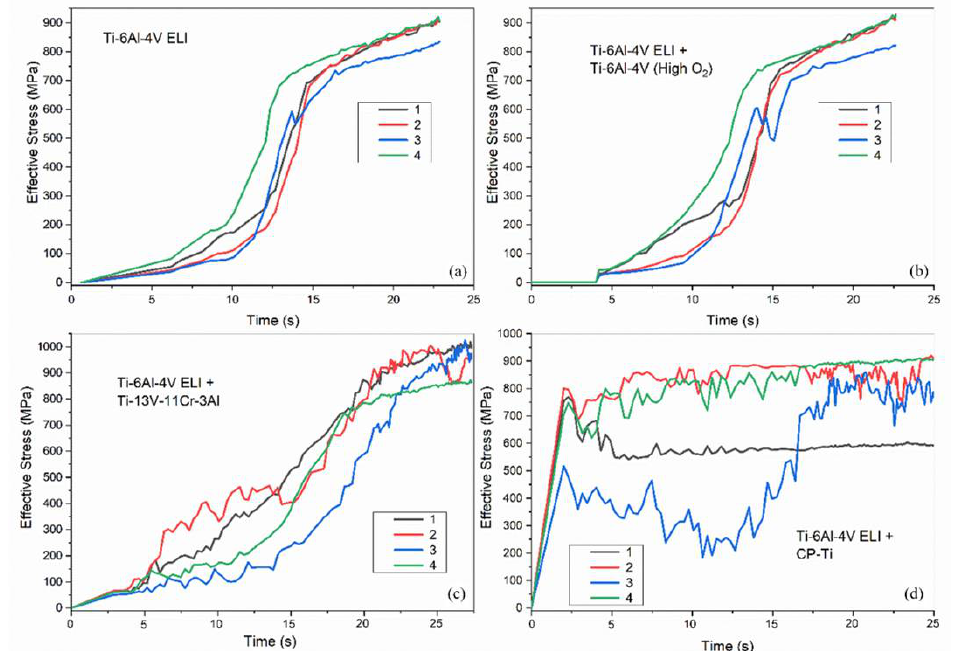
Figure 8. Effective stress at the four different points varies with time ( a ) Part 1, ( b ) Part 2, ( c ) Part 3, and ( d ) Part